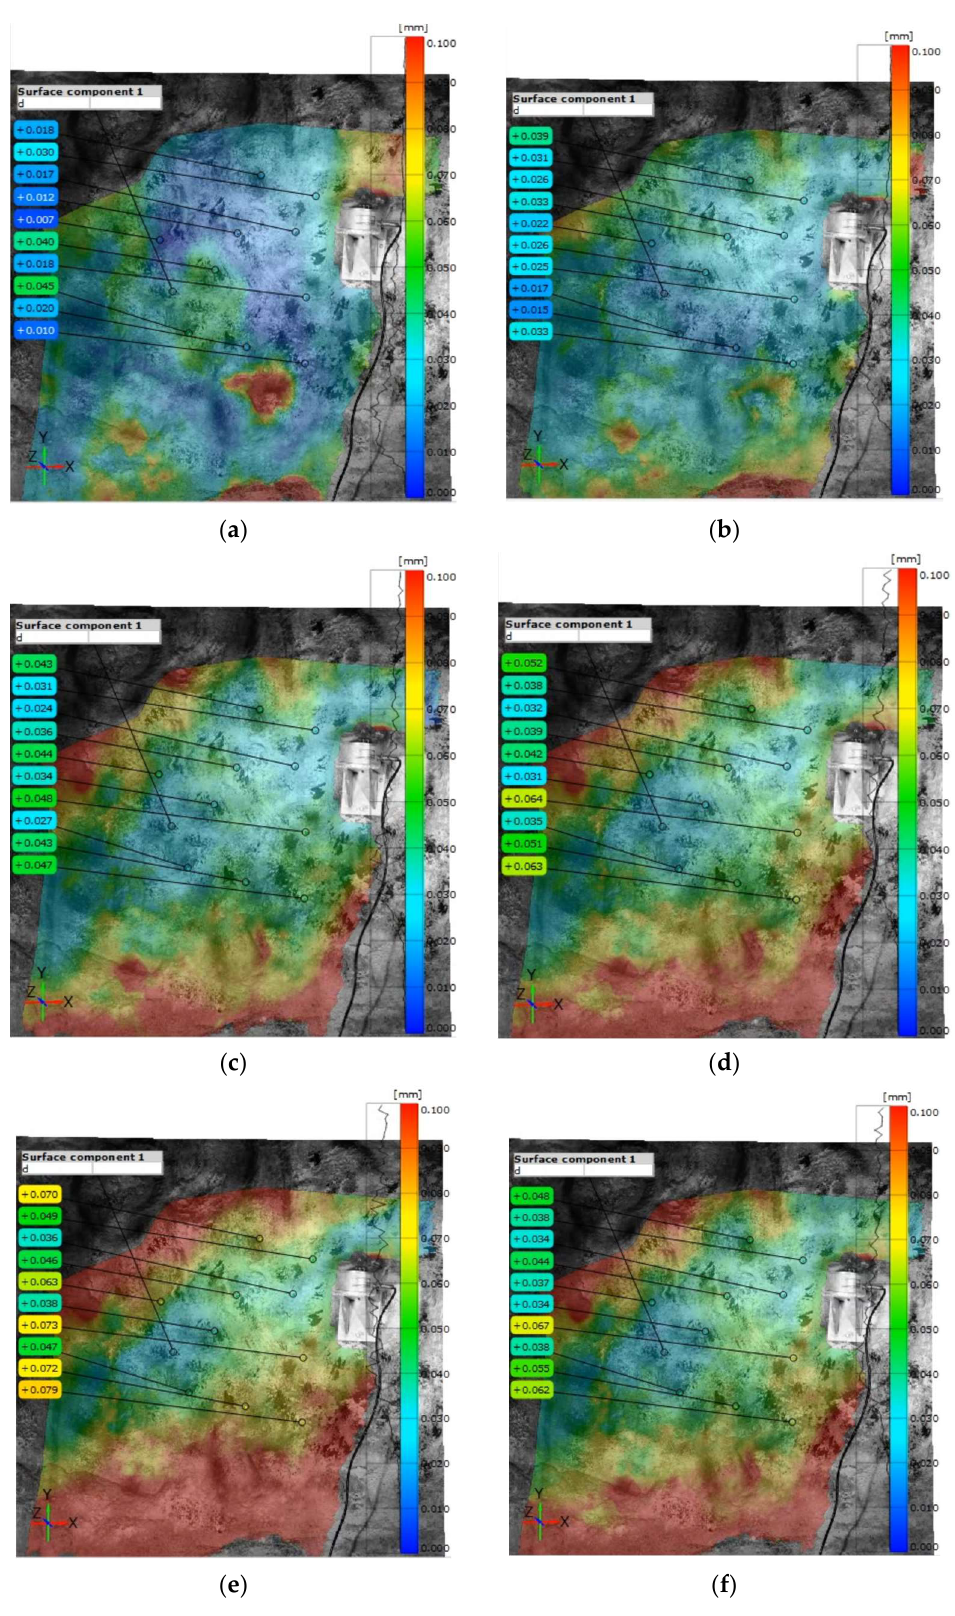
Figure 6. Displacement of rock pillars ROI at each timepoint after experimental blasting: ( a ) 2 s, ( b ) 4 s, ( c ) 6 s, ( d ) 8 s, ( e ) 10 s, and ( f ) 12 s.